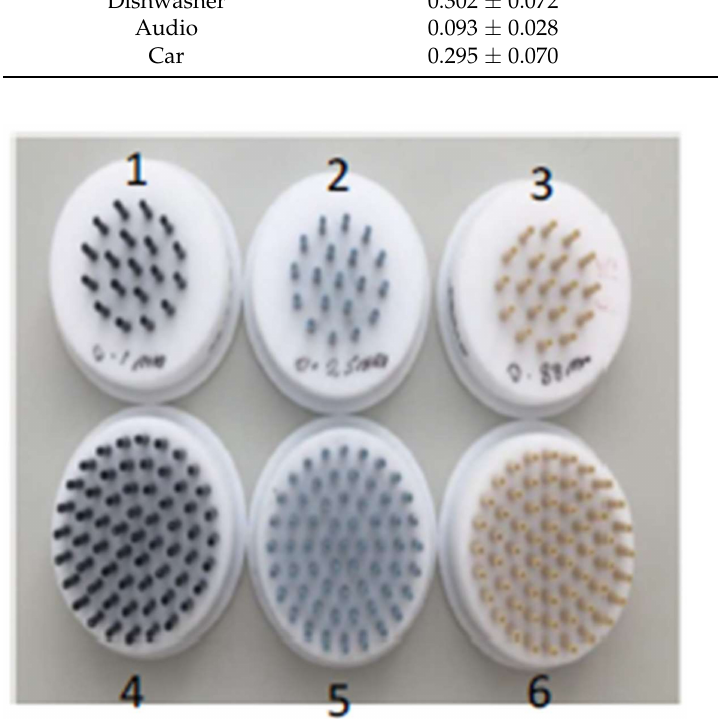
Figure 2. The six capillary substrates considered for the project to model incompressible porous substrates of varying pore size and pore arrangements. 1. shows 0.1 mm small arrangement of capillaries, 2. shows 0.25 mm small arrangement of capillaries, 3. shows 0.88 mm small arrangement of capillaries, 4. shows 0.1 mm large arrangement of capillaries, 5. shows 0.25 mm large arrangement of capillaries, and 6. shows 0.88 mm large arrangement of